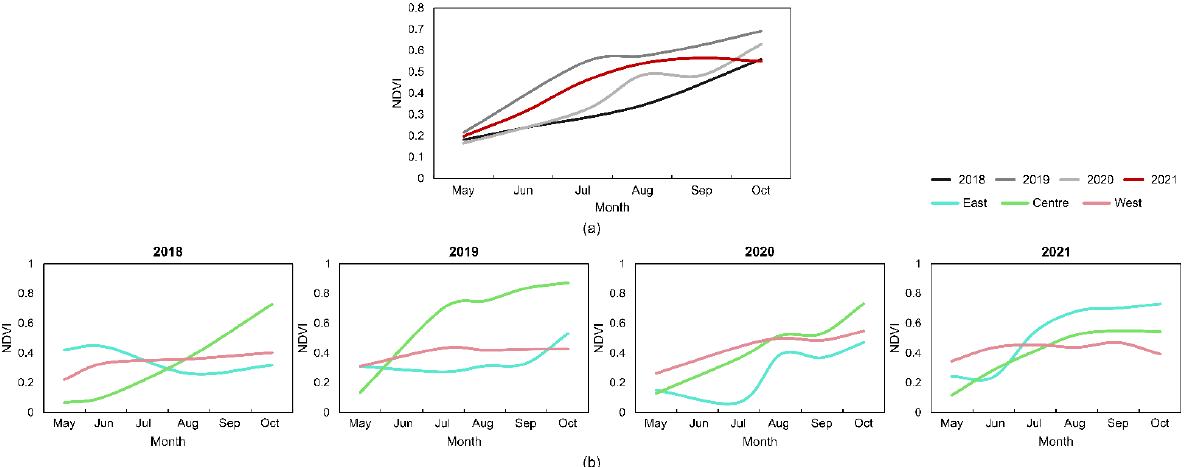
Figure 6. Mean normalized difference vegetation index (NDVI) temporal evolution in each year, from May to October, for the whole study area ( a ) and in each analyzed water channel ( b ).